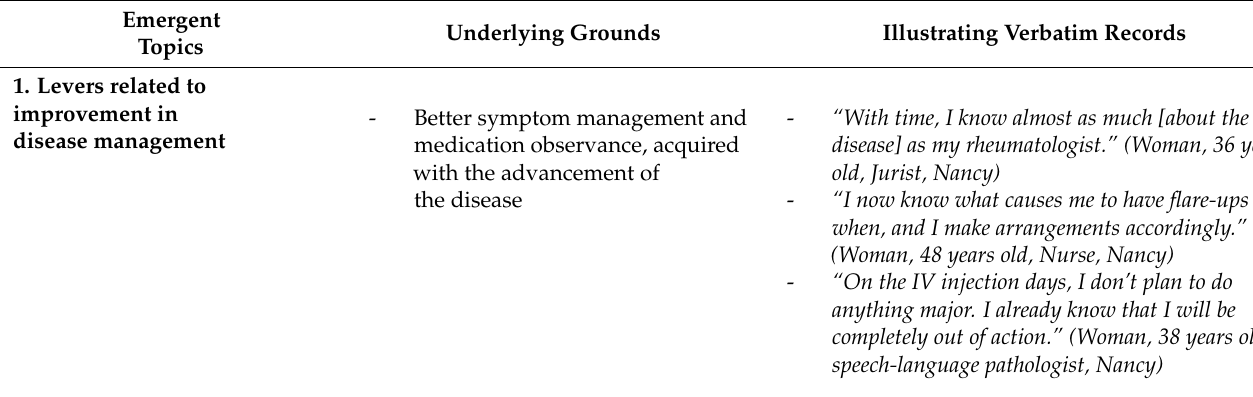
Table 2. Emergent topics of the